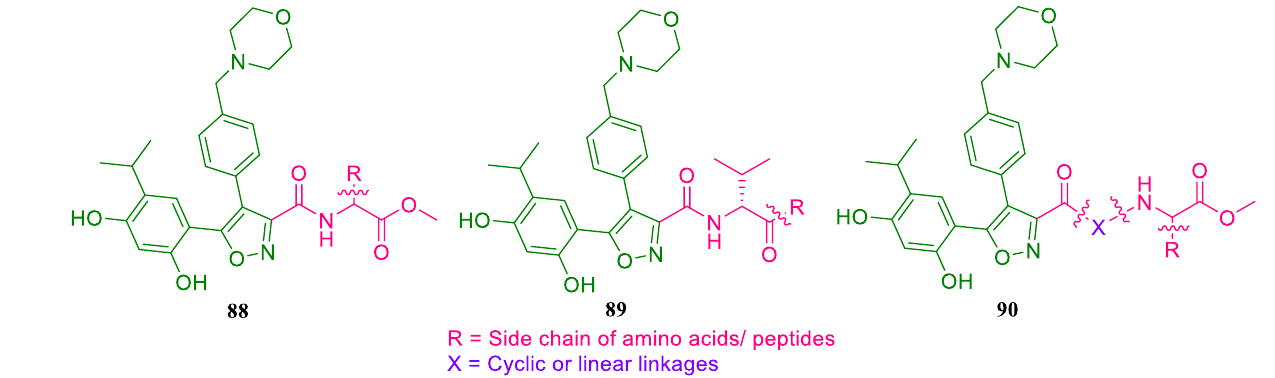
Figure 72. 4,5-diarylisoxazoles conjugated to amino